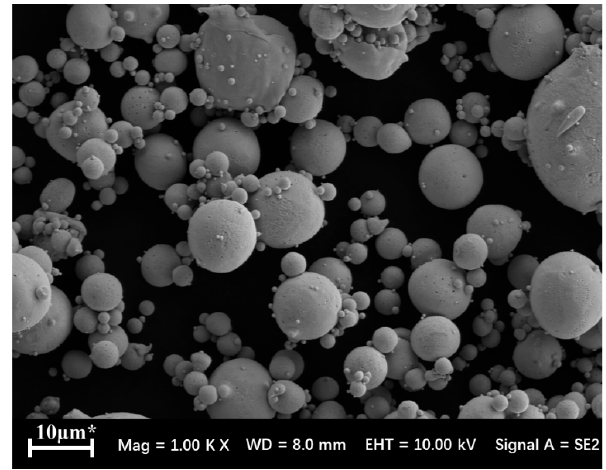
Figure 1. Particles of Ag68.8Cu26.7Ti4.5 powder (SEM).